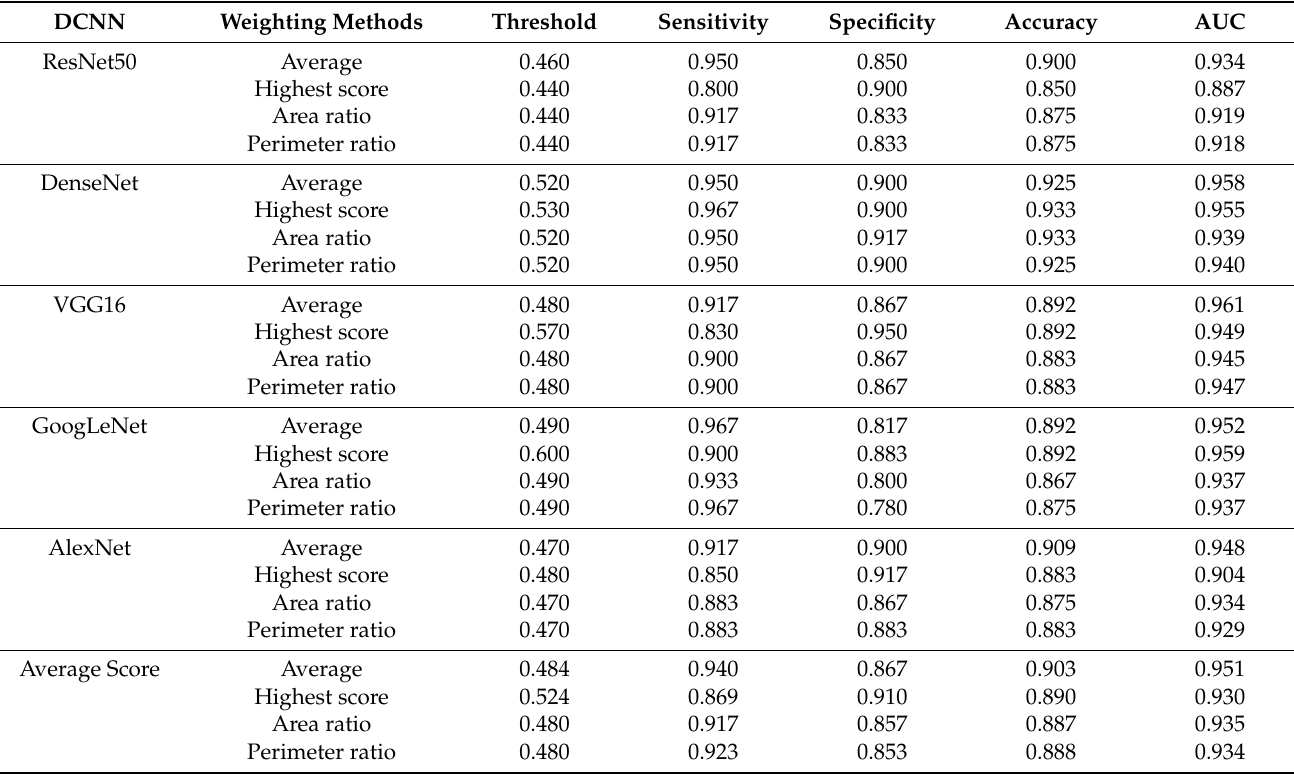
Table 5. Performance of BC classification of five DCNNs with different weighting methods based on SBBS-ROI on testing